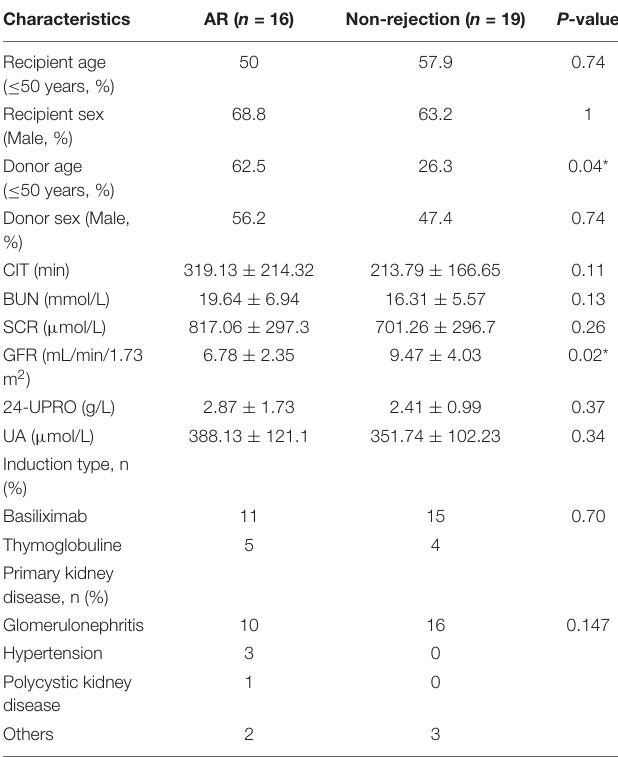
TABLE 2 | Demographic and clinical characteristics of kidney allograft